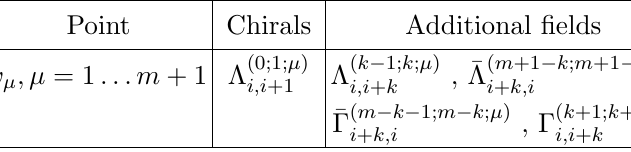
C m +2 partial resolution for m = 1 ; !